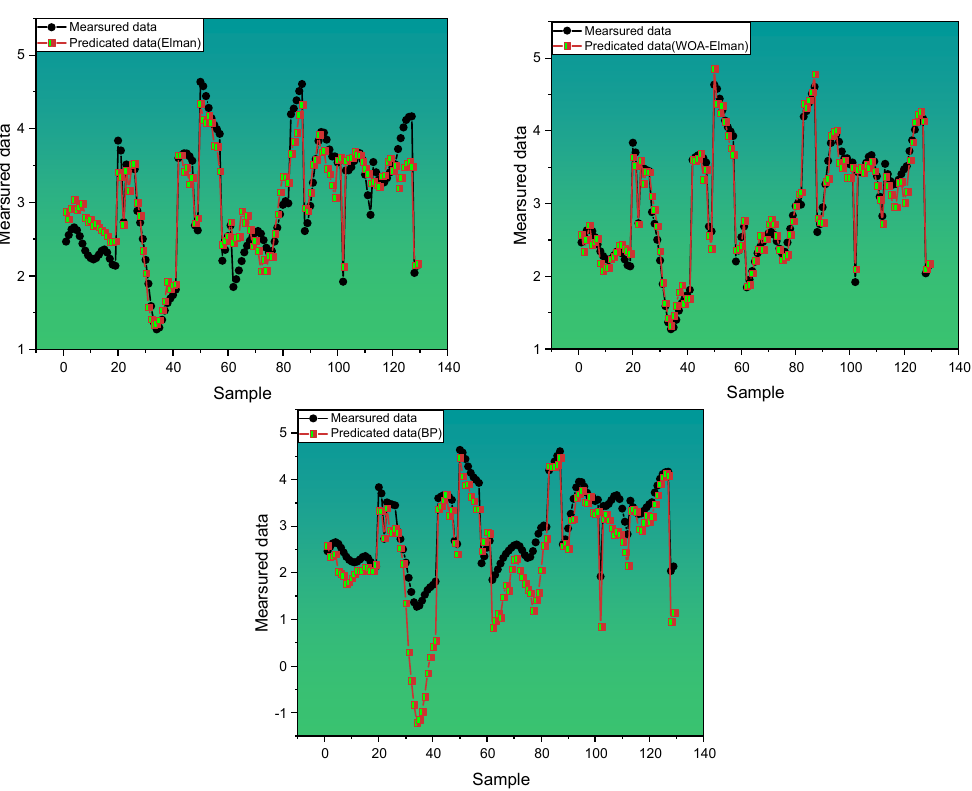
Figure 8. Broken line diagram of predicted value and real value of three machine learning models based on test set.